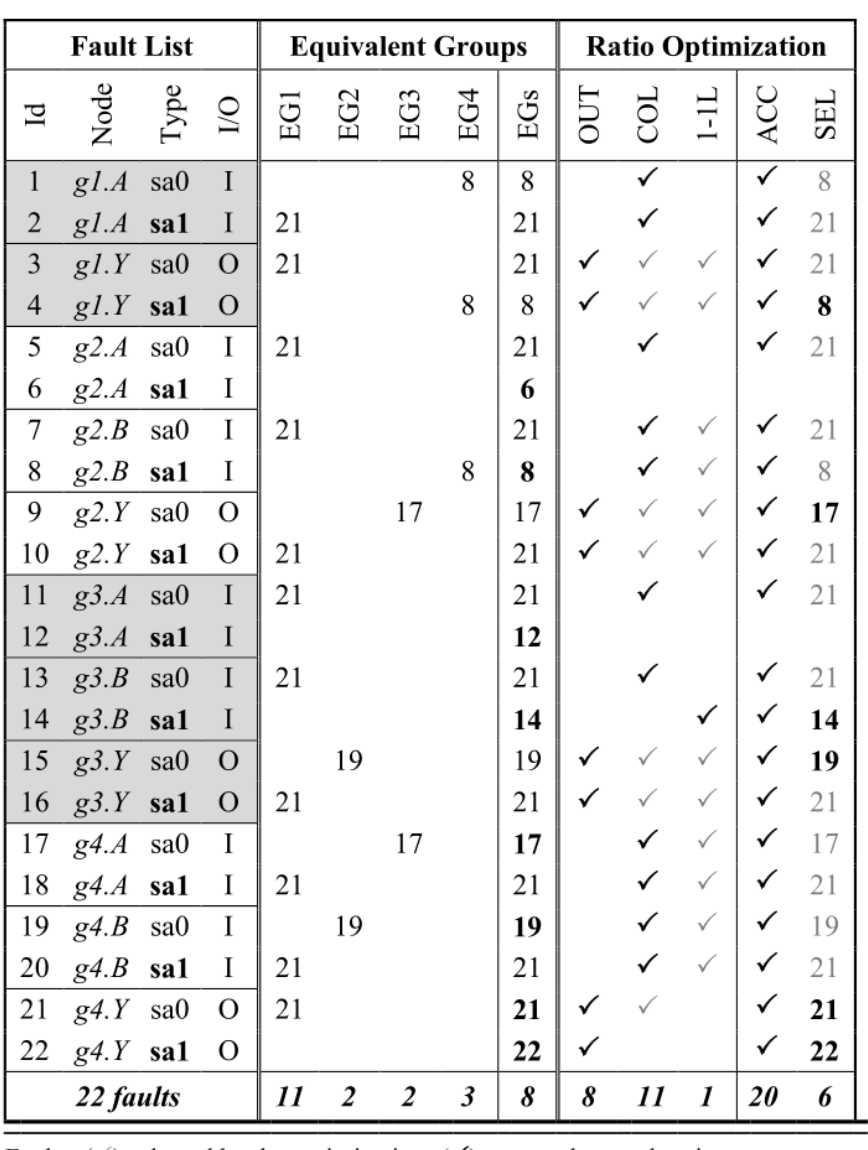
Figure 4. Fault list analysis for the MUX